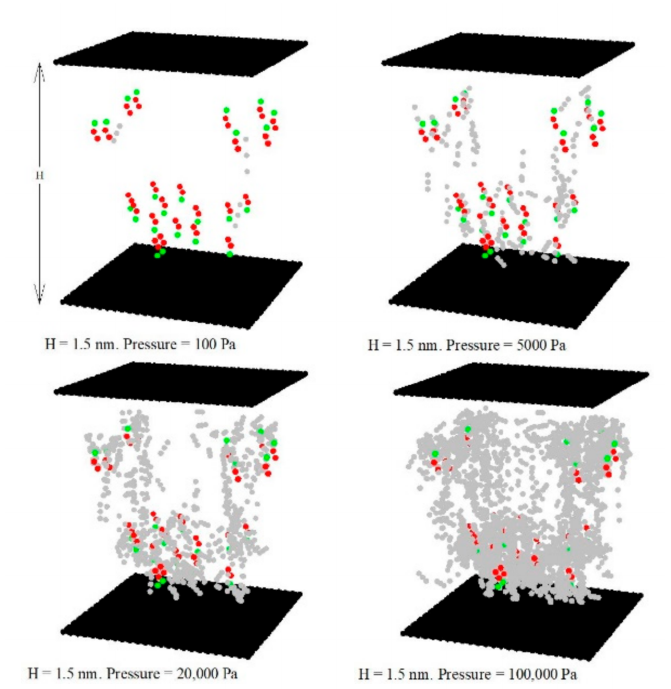
Figure 8. Snapshots of carbon dioxide adsorption at 273 K in pores of width 1.5 nm with the presence of NaOH molecules for various pressures, 100, 5000, 20,000, and 100,000 Pa. (green spheres, red spheres, and gray spheres represent Na atoms, OH groups, and carbon dioxide molecules, respectively).